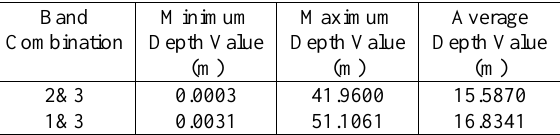
Table 2 . Statistic Values of Depth Estimation from SDB.